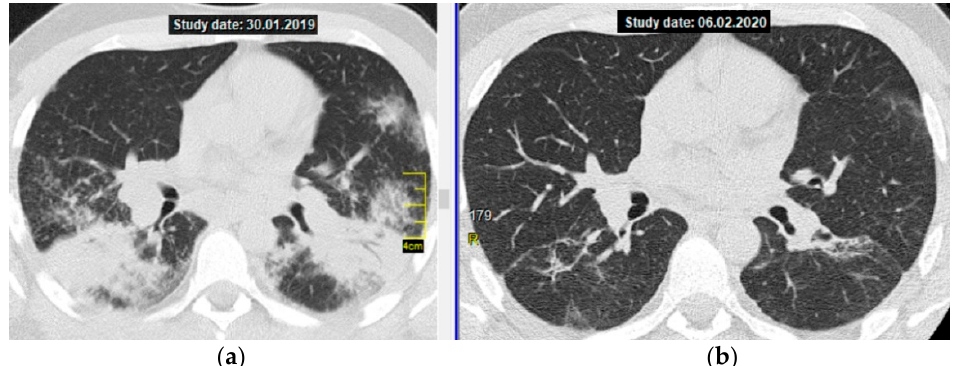
Figure 2. Pulmonary sarcoidosis, stage II, atypical form—multiple massive consolidations in both lungs; a thoracic CT scan (axial section at the level of division of the main bronchi): ( a ) on the left—before treatment, ( b ) on the right—after 12 months of MTX therapy, 15 mg/week (complete resolution with residual changes in the form of limited interstitial fibrosis).